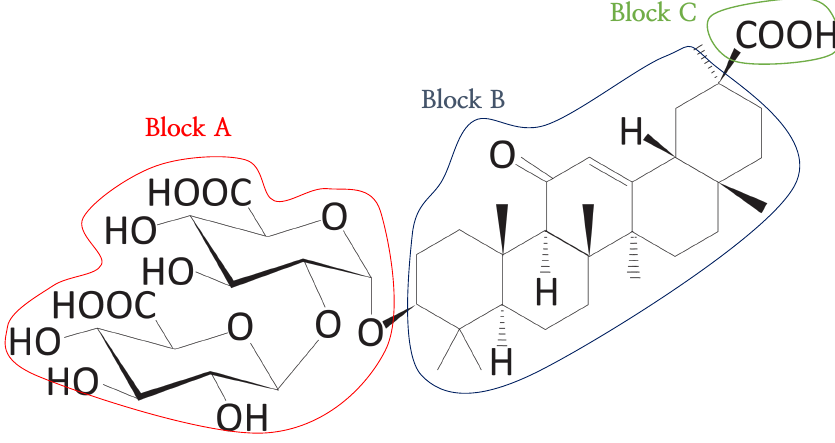
Figure 11. The triblock form of DB13751. The red and green line areas represent the hydrophilic blocks, and the blue line area represents the hydrophobic group derived from the clustering process. We call the red line area Block A, the blue line area Block B, and the green line area Block C. These blocks are used to calculate the